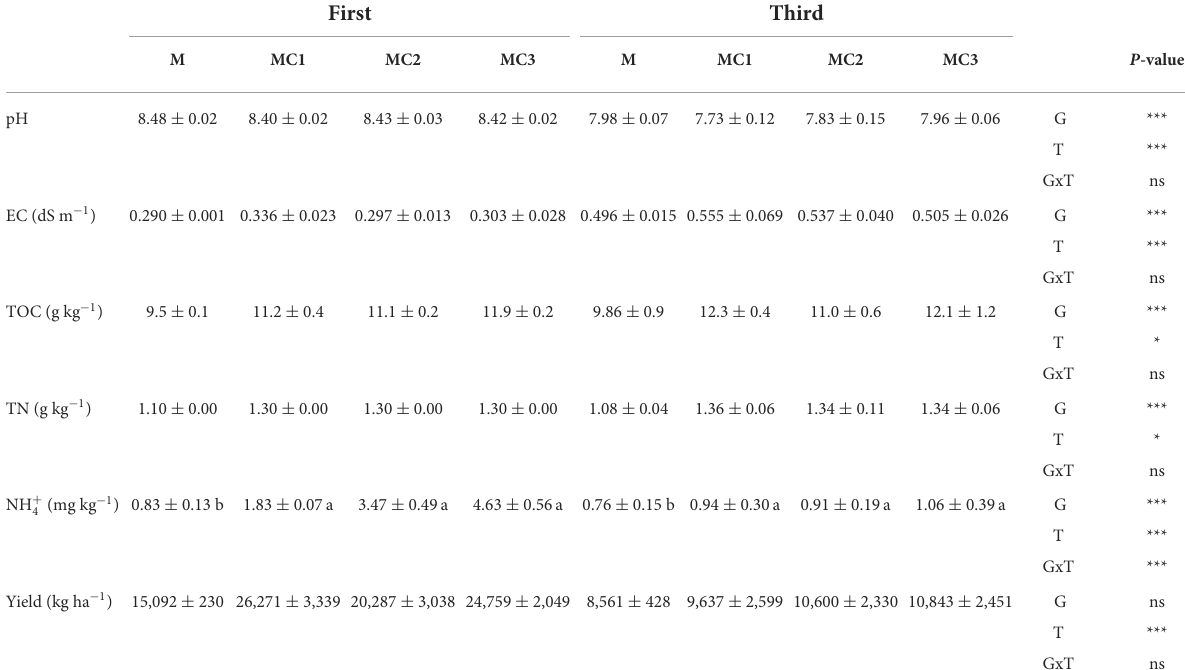
TABLE 1 Different soil properties and harvest in different sampling times and cropping systems. First Third M MC1 MC2